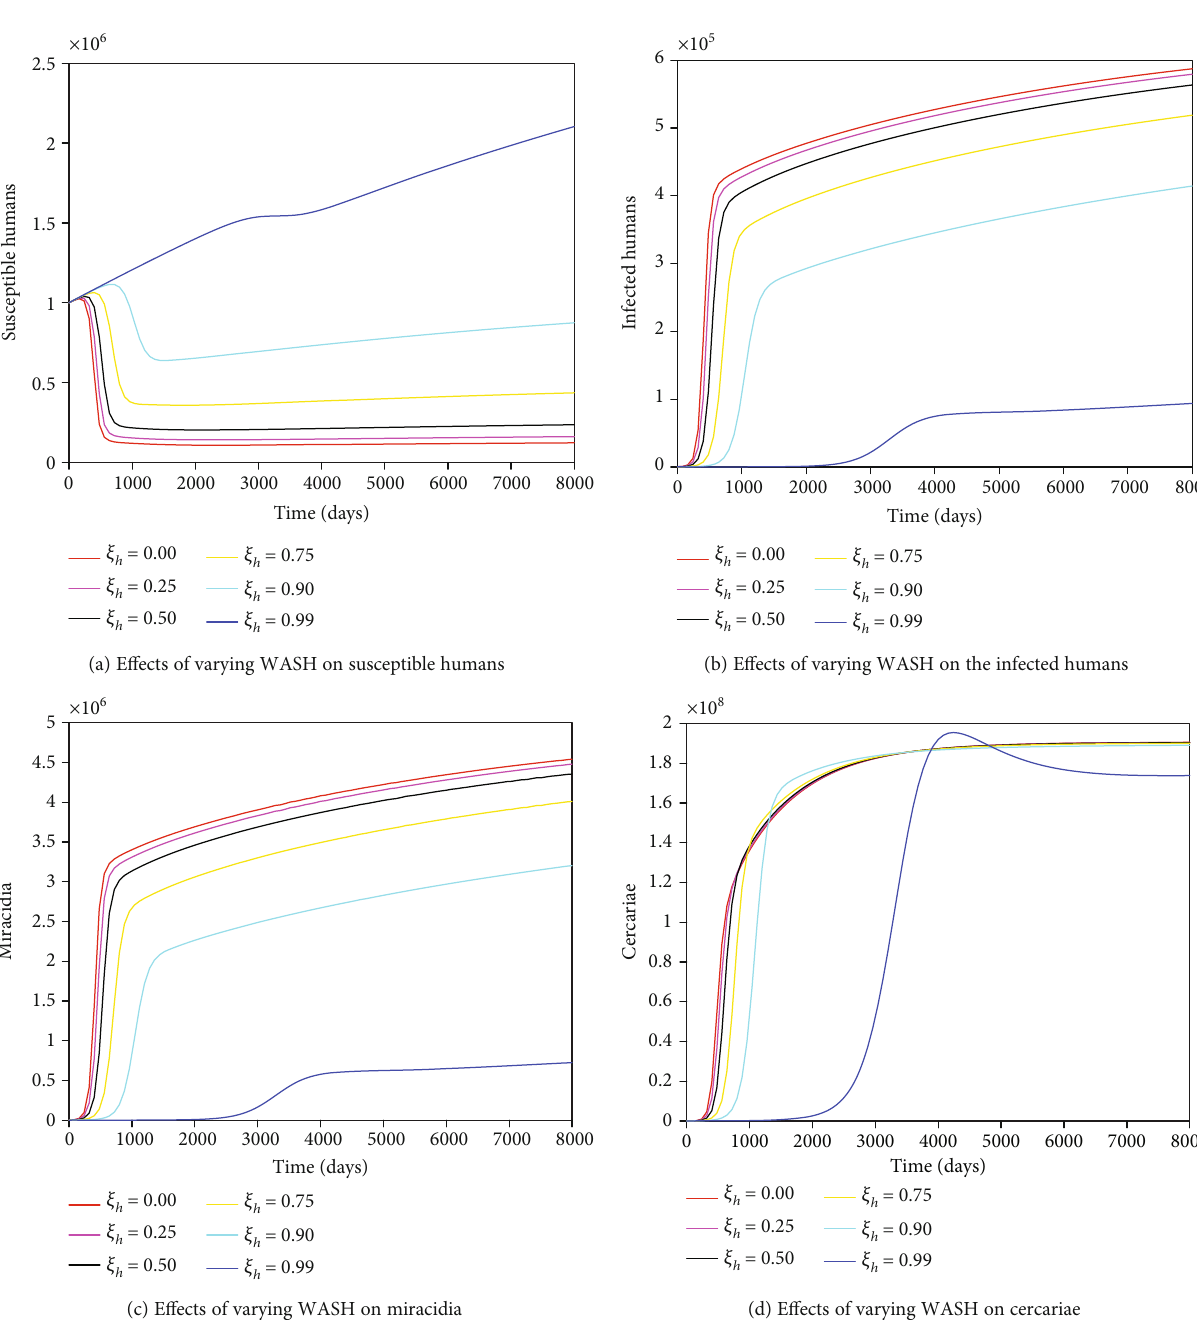
Figure 4: E ff ects of WASH on the dynamics of humans and the